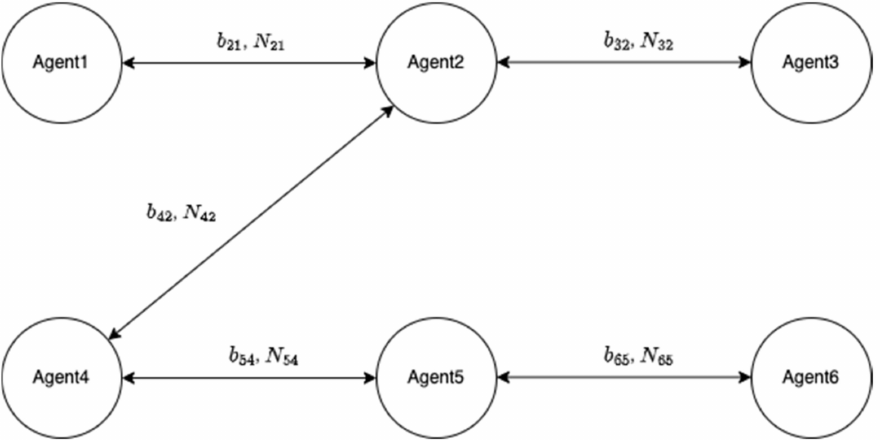
Figure 5. There are six agents in a group of UVs wherein five baselines and DD integer ambiguities are assumed to be correctly determined.